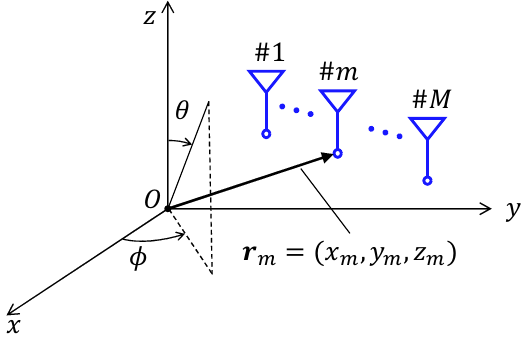
Figure 4. Multiple antennas in the three-dimensionally defined